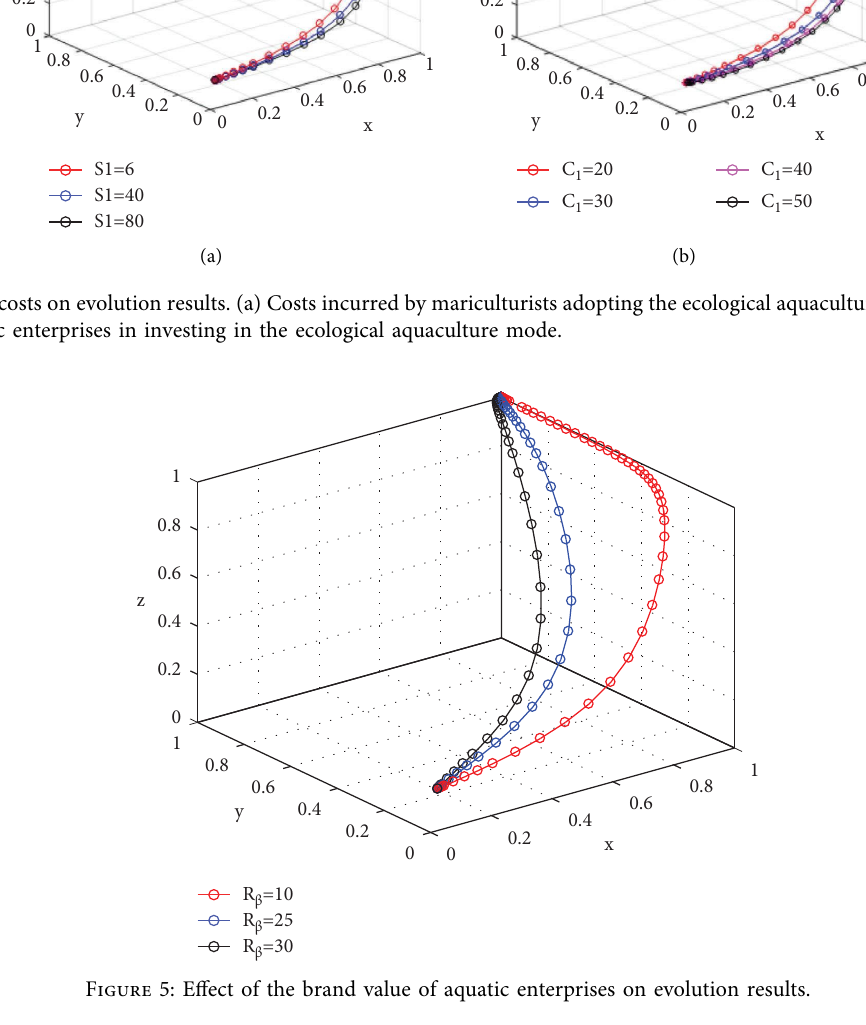
Figure 5: Efect of the brand value of aquatic enterprises on evolution